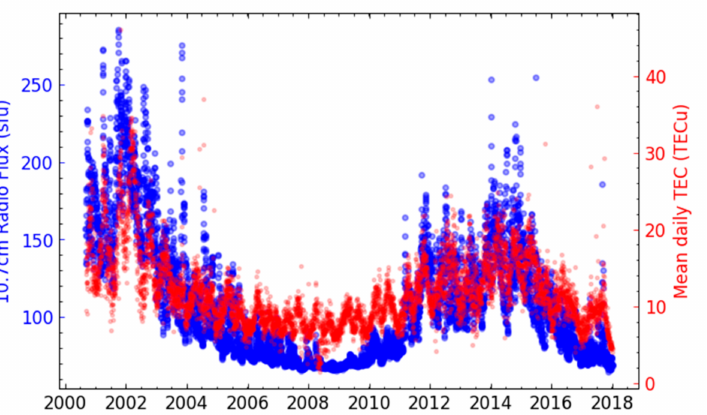
Figure 2. Solar activity expressed as 10.7 cm radio flux (blue) and mean daily ionospheric TEC values as calculated for IGS Noto (red) for the approximate period 2001 to